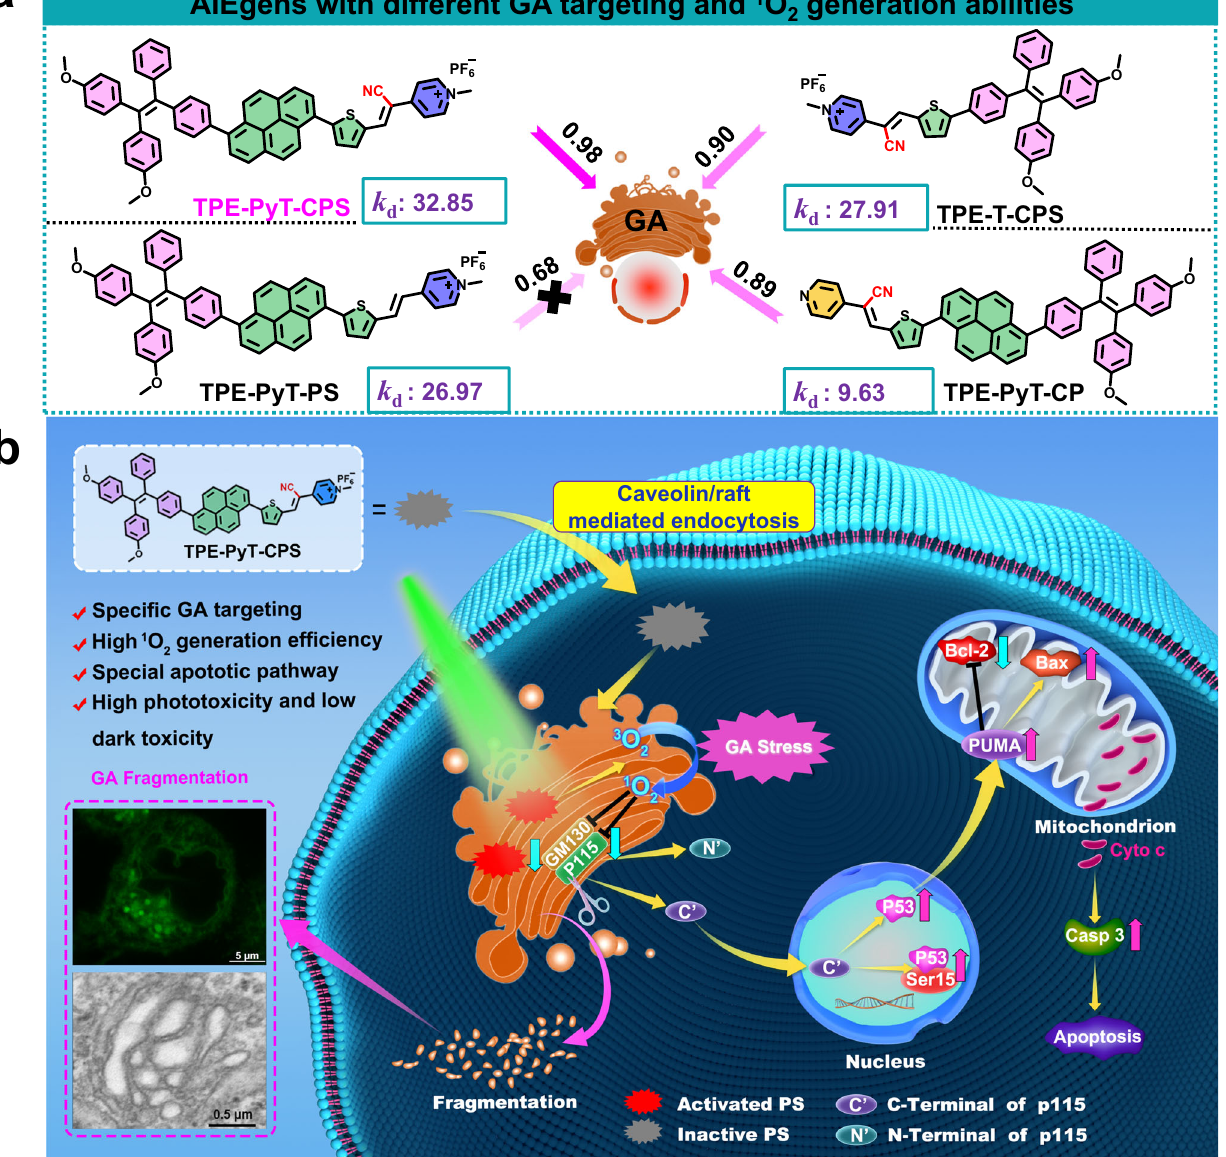
Fig. 1 GA targeting and ROS generation capacity of the AIEgens, as well as the apoptosis pathway caused by Golgi oxidative stress. a The chemical structures of AIEgens with different GA targeting (PCC values) and ROS generation abilities ( k d : nmol/min): decomposition rates of ABDA in the presence of different AIEgens. b Schematic illustration of AIEgen induced GA stress and the crosstalk between GA and mitochondria for cell apoptosis upon